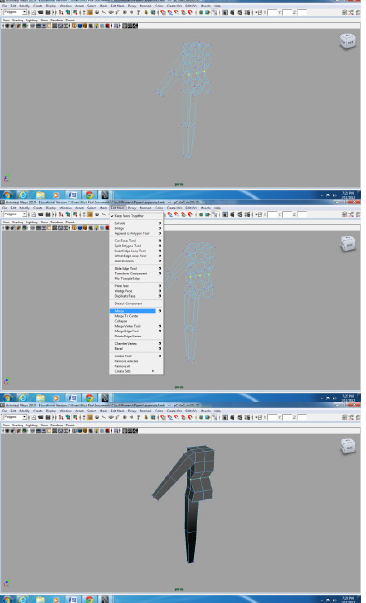
Figure 17. Merge Operation Applied to the Back Wedge Vertices